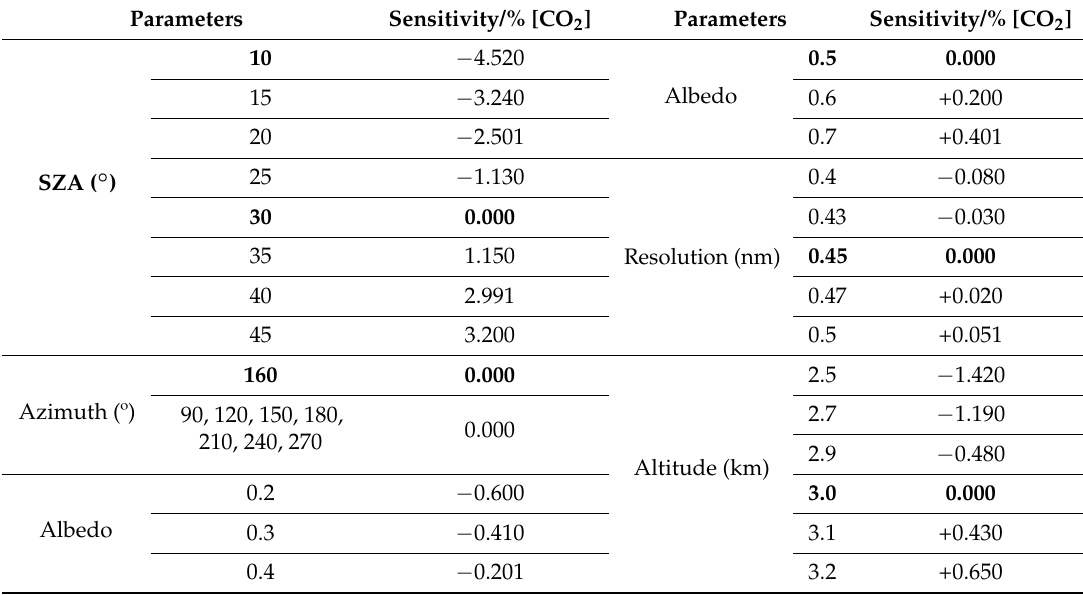
Figure 8. CO 2 CWF at different ( a ) SZAs, ( b ) azimuth angles, ( c ) surface albedo, ( d ) resolutions, and ( e ) output heights. Table 5. Sensitivity of CO 2 column under the aircraft.